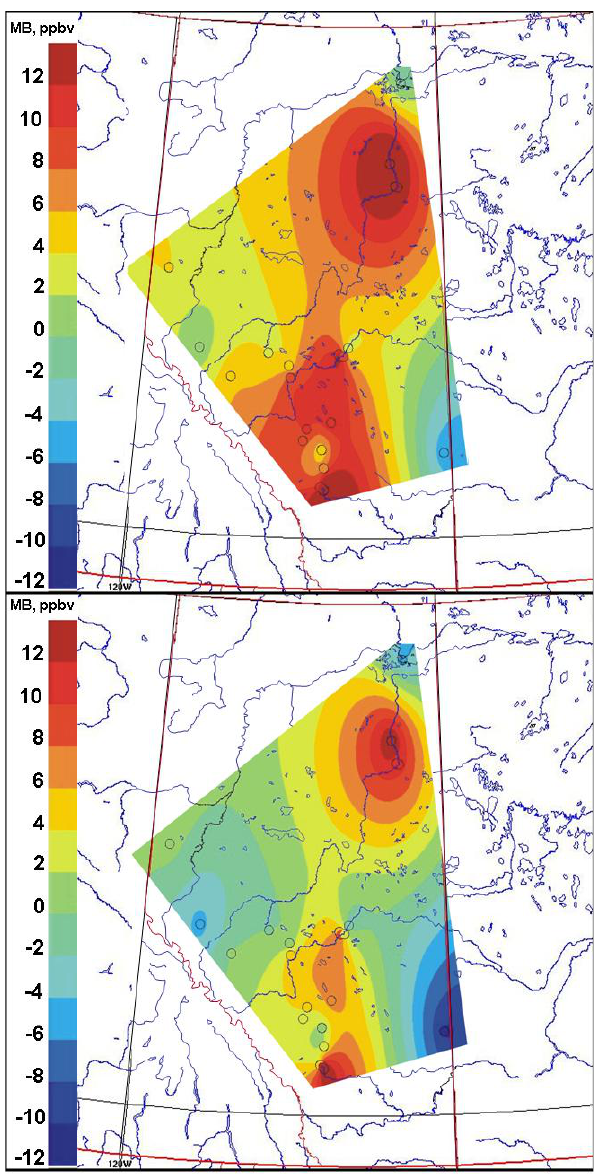
Fig. 12. Kriged surface daily 1hr maximum ozone, western Canada summer 2002 simulations. (a) Base Case, (b) Opt1 Dyn Extrap2 Wosp scenario.